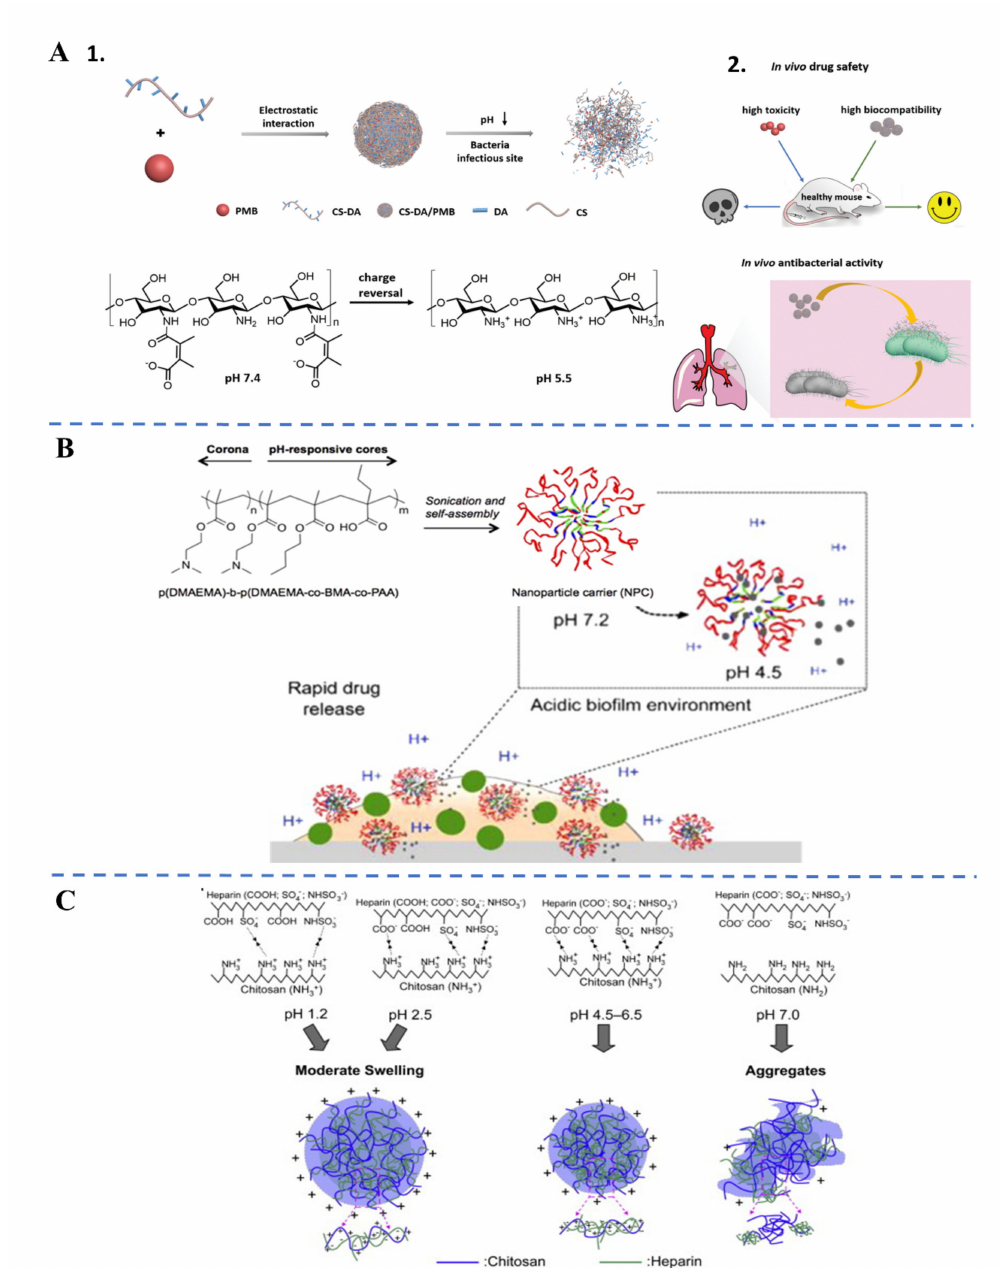
Figure 4. Examples of pH-responsive nanocarriers for antibiotic delivery. ( A ) ( 1 ) Schematic illustration of a pH-sensitive polyion nanocomplex for delivery of Polymyxin B (PMB). The NPs were prepared through electrostatic interaction of positively charged PMB and negatively charged 2,3-dimethyl maleic anhydride (DA)-grafted chitoligosaccharide (CS). ( 2 ) Schematics of in vivo drug safety, different from free PMB and CS-DA/PMB, and the mechanism of antibacterial activity of CS-DA/PMB (reprinted with permission from [48], copyright 2020 John Wiley and Sons). ( B ) The self-assembly structure and mode of action of acidic pH-sensitive micelles in delivering antibacterials in cariogenic dental biofilms (adapted with permission from (19), copyright 2015 ACS). ( C ) Illustrations of the physical structures of chitosan/heparin pH-sensitive NPs, an application in the treatment of H. pylori infection (reprinted with permission from [49], copyright 2009